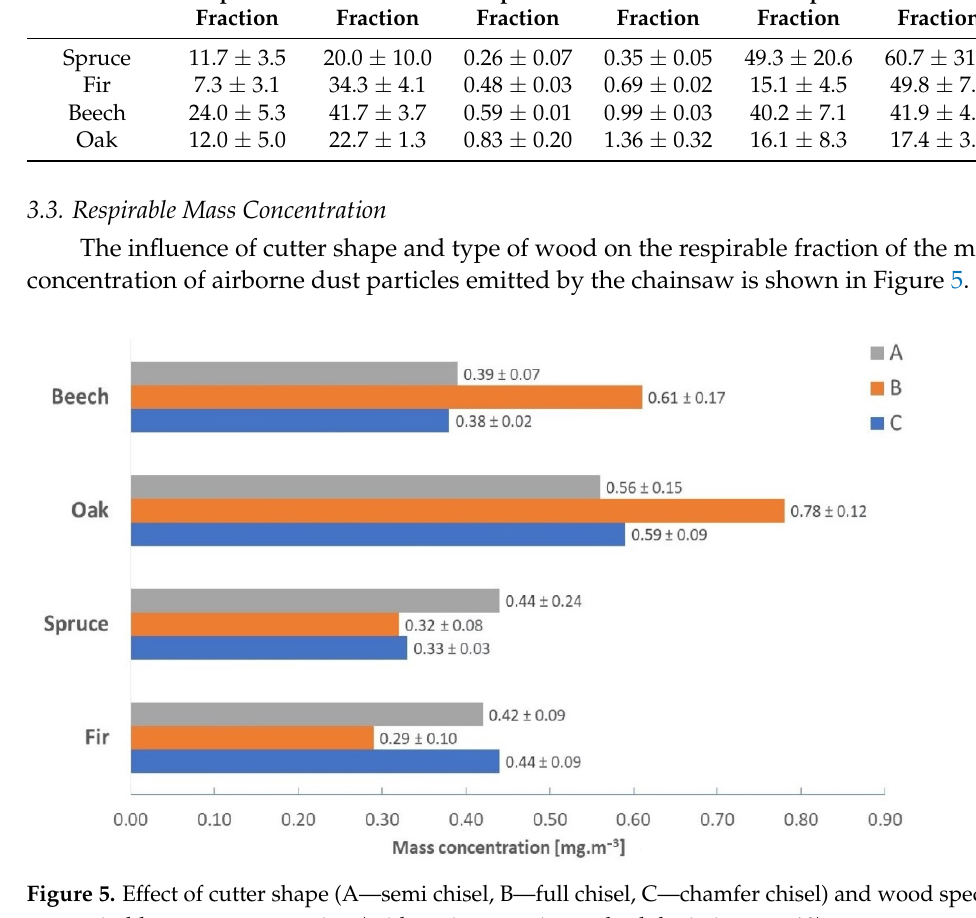
Table 2. Results of split-plot ANOVA on respirable mass concentration data.